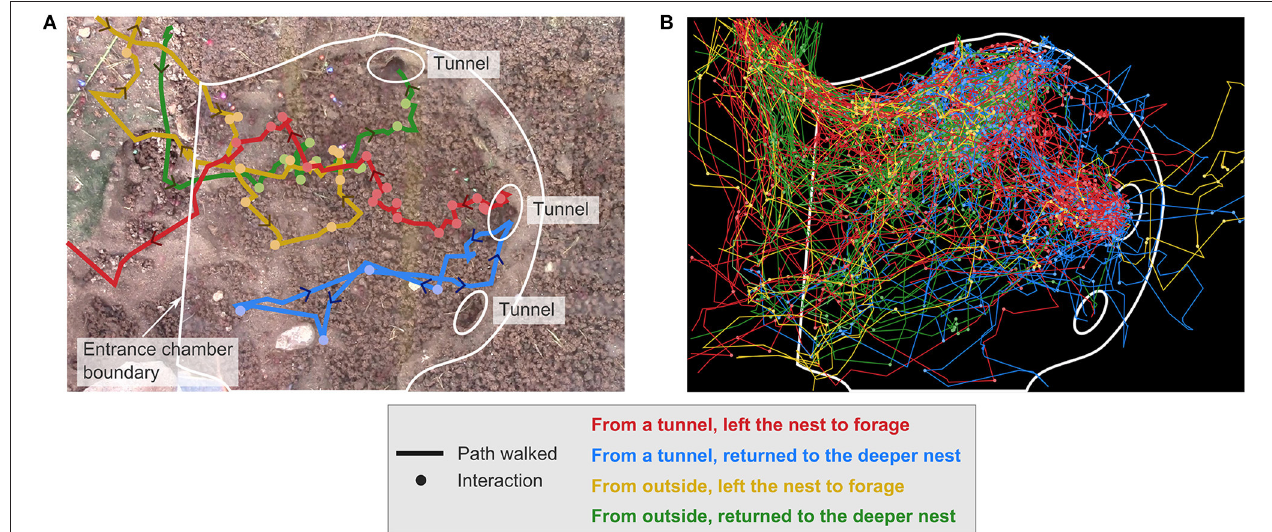
FIGURE 2 | Trajectories of returning and potential foragers, grouped by start location and end action. A potential forager comes from a tunnel into the entrance chamber and either leaves the nest to forage (red) or returns to the deeper nest (blue). A returning forager comes into the entrance chamber from outside the nest and either leaves the nest to forage (yellow) or returns to the deeper nest (green). This example from colony 1 shows: (A) One ant in each category, and (B) All tracked ants in each